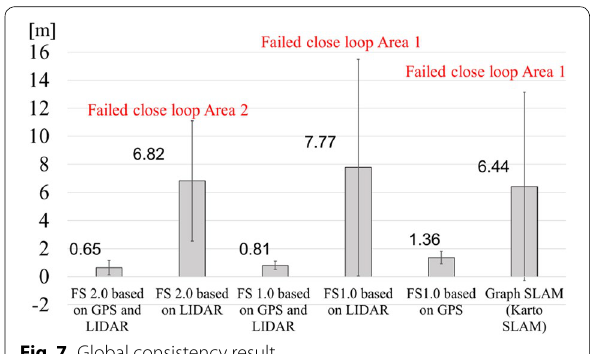
Fig. 7 Global consistency result